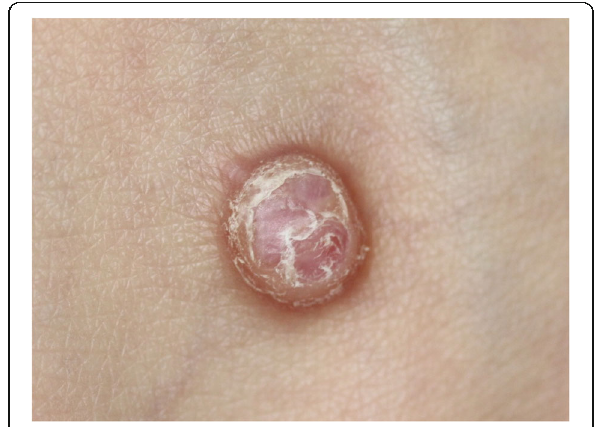
Fig. 1 Macroscopic appearance of the ECH. The lesion presented as a 1-cm exophytic, reddish, and hyperkeratotic nodule